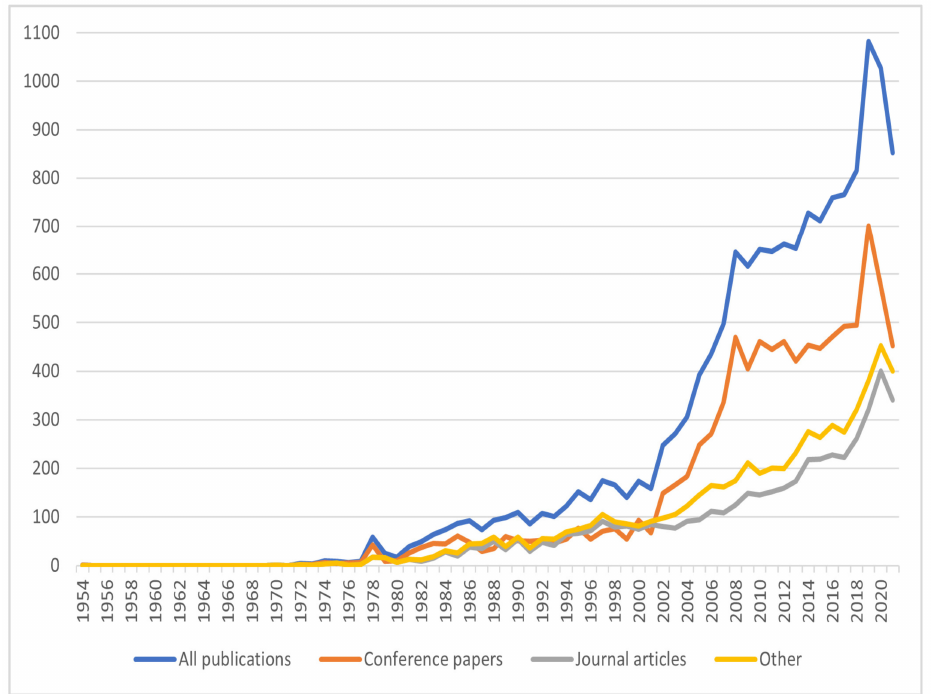
Figure 1. Thedynamicsofthesoftwarequalityresearchexpressedbythenumberofpeer-reviewedpublications. Spatial Distribution and Productivity of Literature